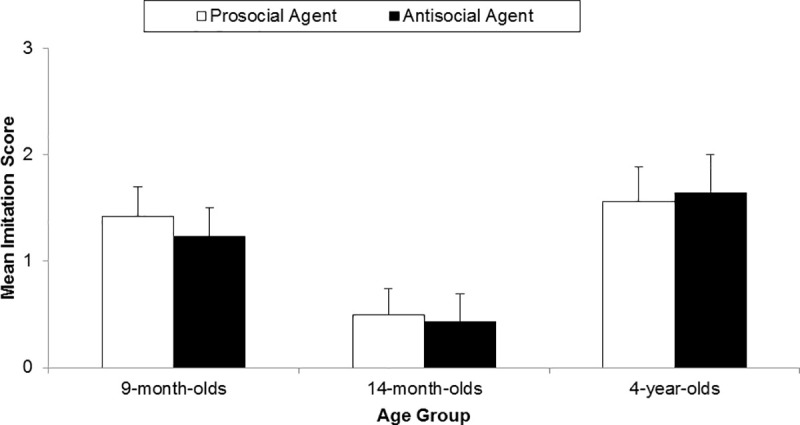
Mean imitation score for the prosocial and the antisocial agent in infants (Experiment 1) and children (Experiment 2).Error bars indicate standard errors.